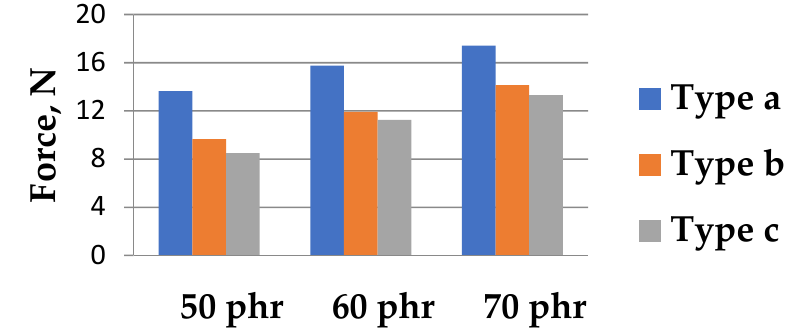
Figure 7. Force at maximum set elongation in strained samples. Figure 6b,d,f exhibit the uniqueness of the results of EER for the used deformation settings. A gradual increase in CB concentration increased the non-monotonic runway of resistance variation. The results are presented in the form of a ratio between variation of